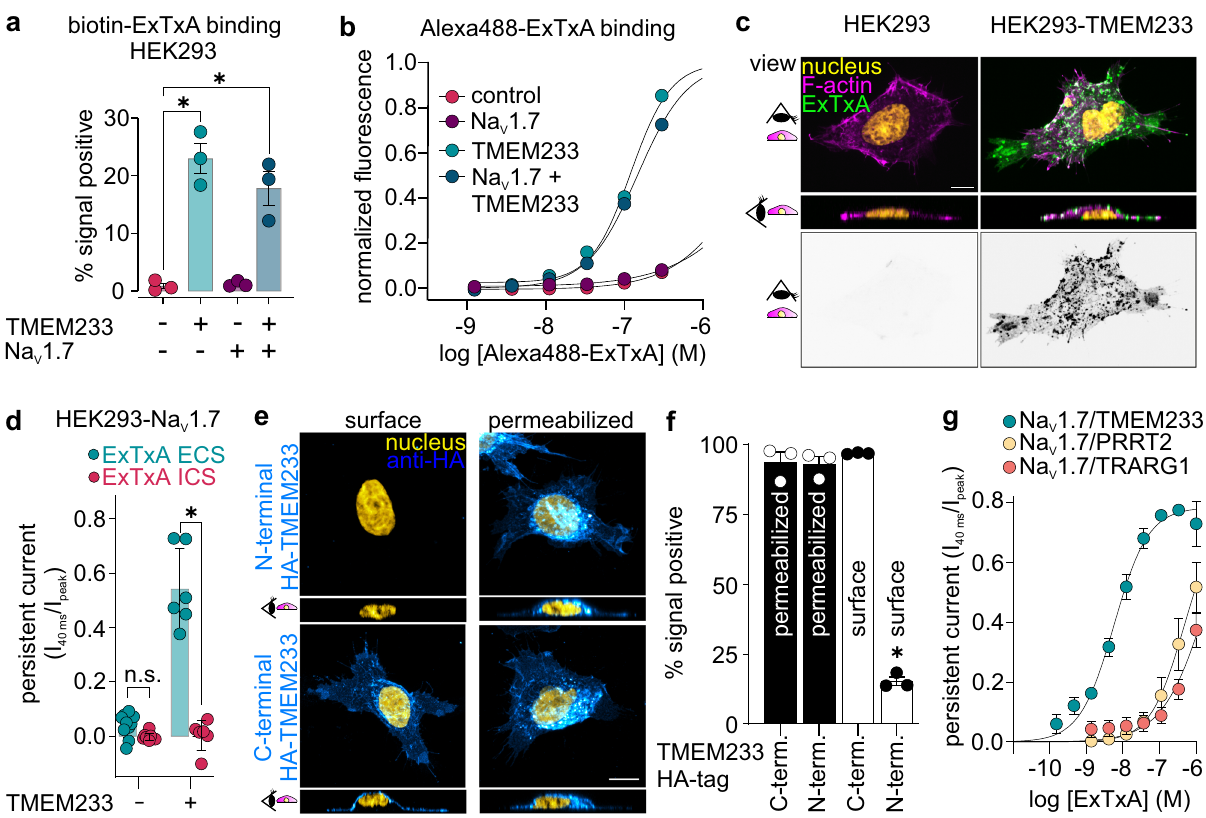
Fig. 4 | ExTxA interacts directly with TMEM233. a Percentage of fl uorescence signal-positive cells, determined by fl ow cytometry, following staining with bioti- nylated ExTxA (1 μ M) and DyLight680-conjugated streptavidin in untransfected or TMEM233-transfected HEK293 and HEK293-Na V 1.7 cells. b Fluorescence intensity following staining with Alexa488-conjugated ExTxA (1 – 300nM) in mock- or TMEM233-transfected HEK293 and HEK293-Na V 1.7 cells. c Confocal microscopy image showing Alexa488-streptavidin signal only in TMEM233-expressing cells